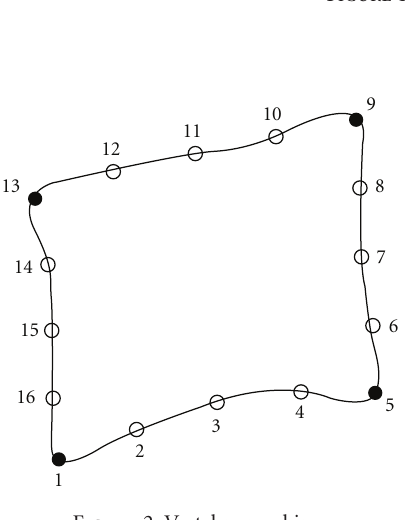
Figure 2: Vertebra marking.